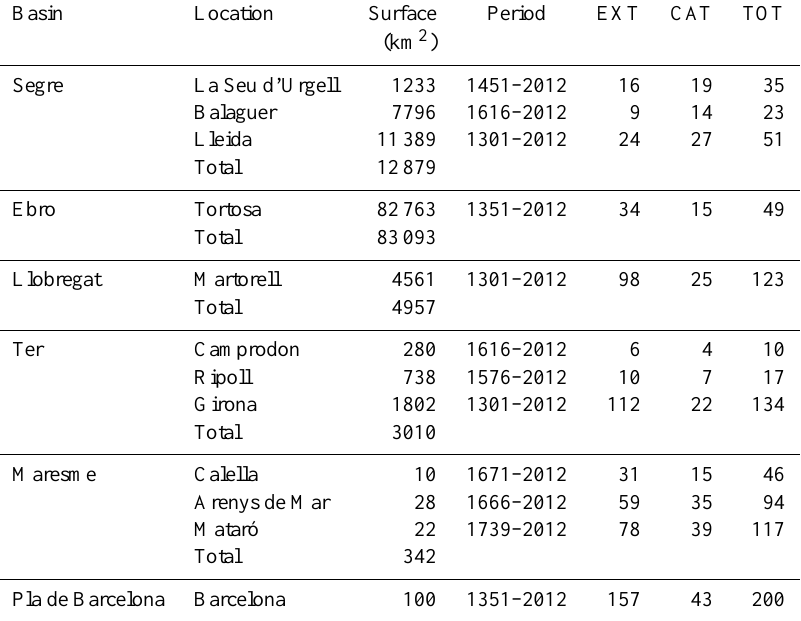
Table 1. Main characteristics of the updated flood chronologies: basins, locations, sub-basin surface at the location, temporal coverage and the number of extraordinary (EXT), catastrophic (CAT) and total (TOT = EXT + CAT) floods. Basin Location Surface Period